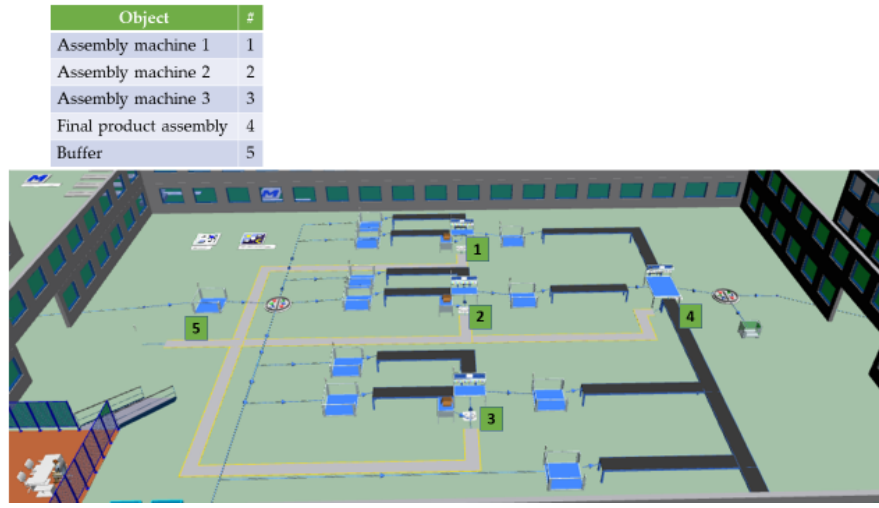
Figure 5. Assembly Area, built through Siemens Plant Simulation.